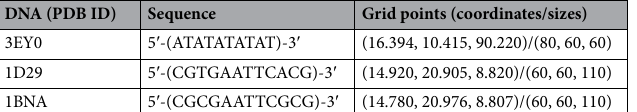
Table 1. PDB entries and grid point data for the three DNA sequences used for the molecular docking